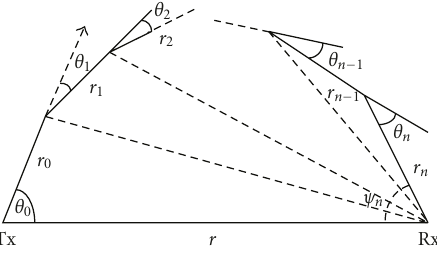
Figure 2: Photon migration path for n